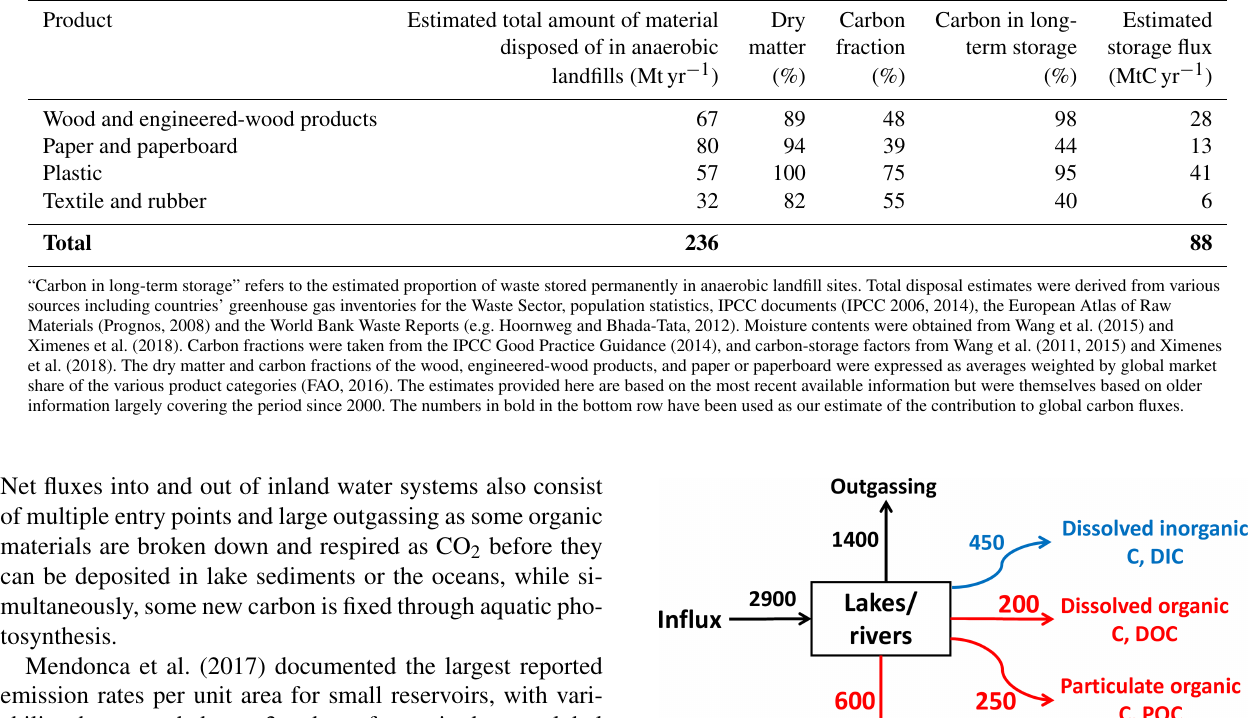
Table 1. Waste generation and estimated disposal in anaerobic landfills. Product